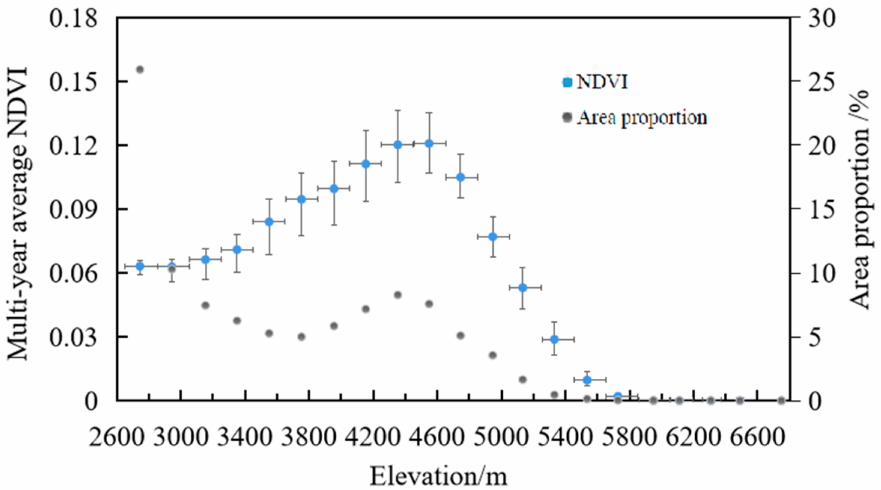
Figure 6. Multi-year average NDVI variations along the elevations.